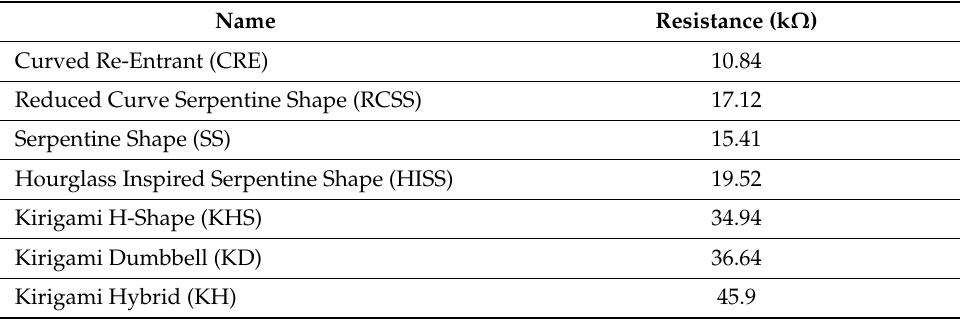
Table 2. Tensile testing parameters for each structure, where lower position limit, gripper displace- ment rate, and sample rate are constant throughout the entire testing